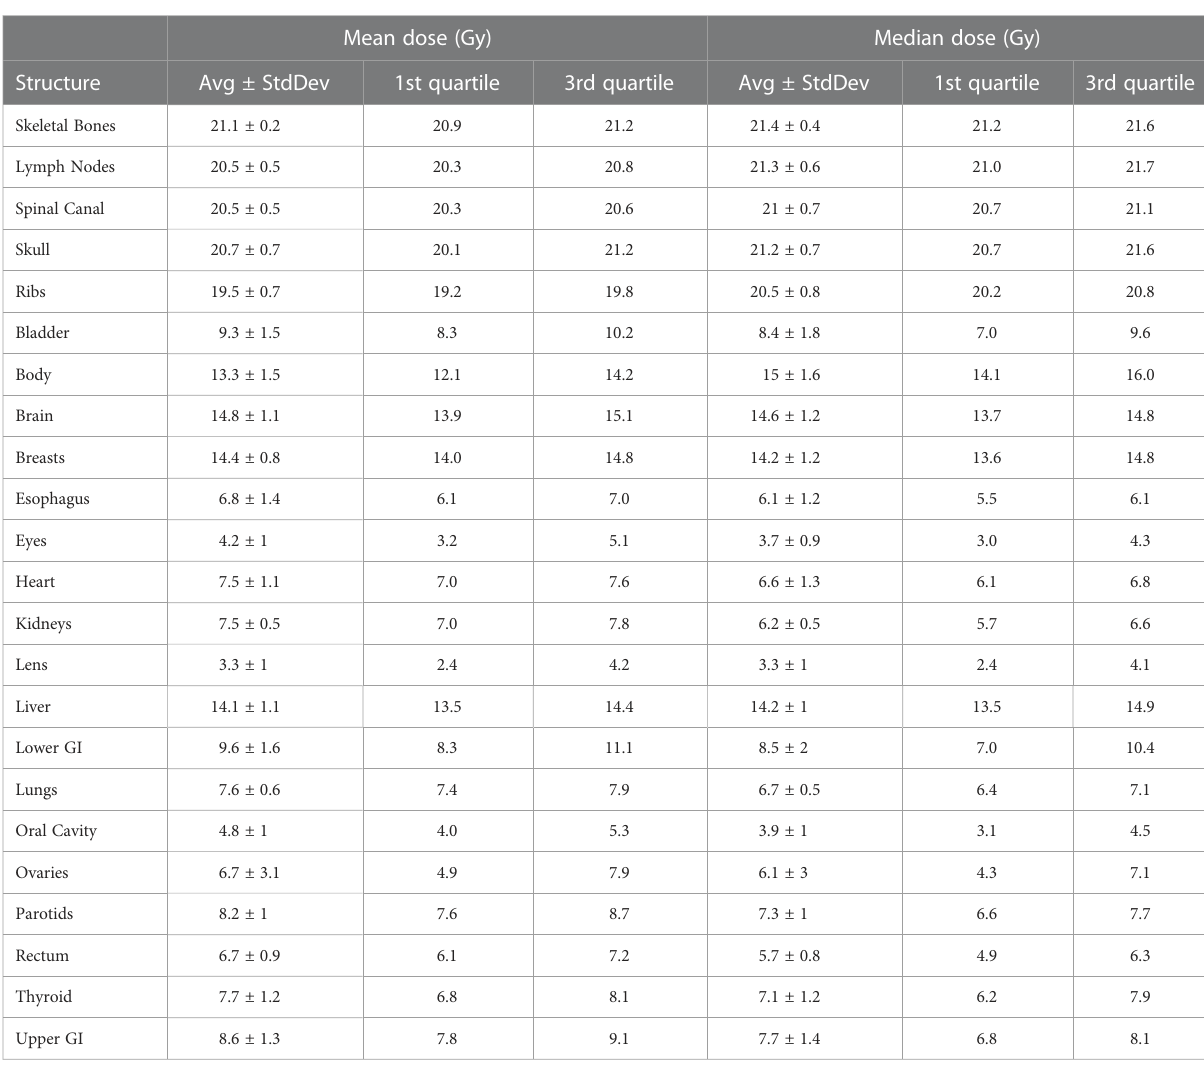
TABLE 2 Statistics of mean dose and median dose (D50) for each structure with the 20-Gy cohort. Mean dose (Gy) Median dose (Gy)